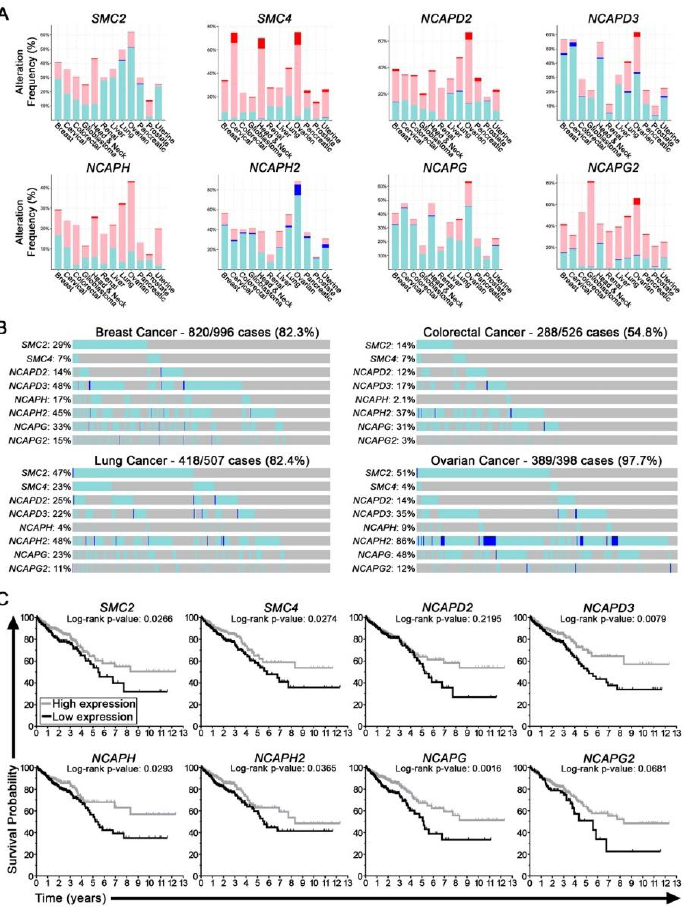
Figure 1. Condensin gene alterations correspond with reduced expression and worse patient survival in cancer. ( A ) Frequency of condensin gene copy number alterations in 12 common cancer types [23]; shallow deletions (aqua), deep deletions (blue), small-scale gains (pink) and large-scale amplifications (red). ( B ) The cumulative frequency of shallow and deep deletions for all condensin genes in breast (82.3%), colorectal (54.8%), lung (82.4%), and ovarian (97.7%) cancers [23]. ( C ) Kaplan–Meier curves reveal that CRCs with reduced condensin gene expression (mRNA) typically correlate with worse overall survival relative to those with high expression [23]. Log-rank tests identify significantly worse outcomes for all genes, with the exception of NCAPD2 ( p = 0.2195) and NCAPG2 ( p = 0.0681), which do show similar